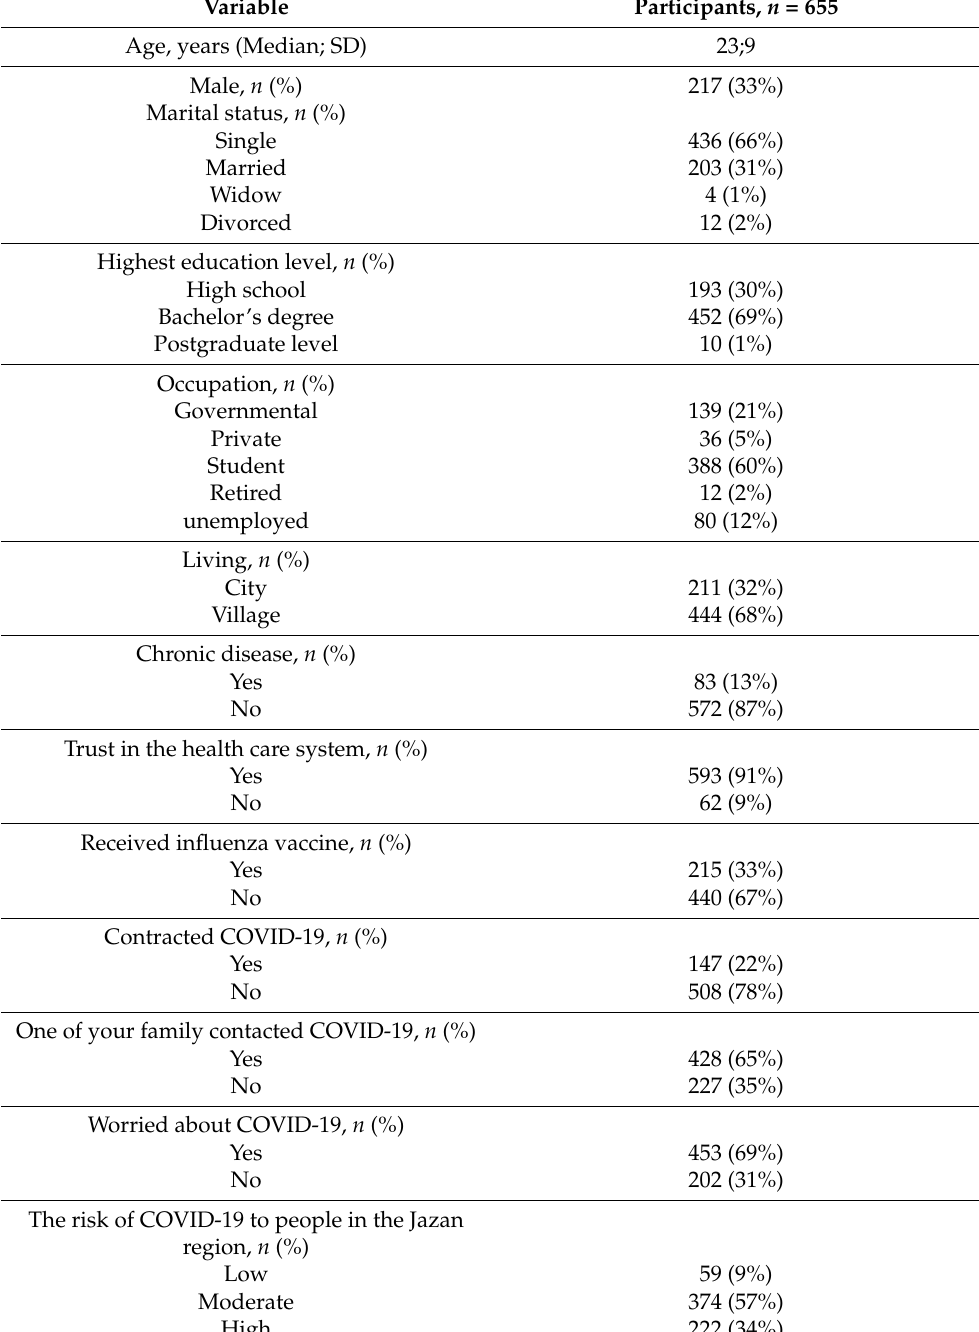
Table 1. General characteristics of the study